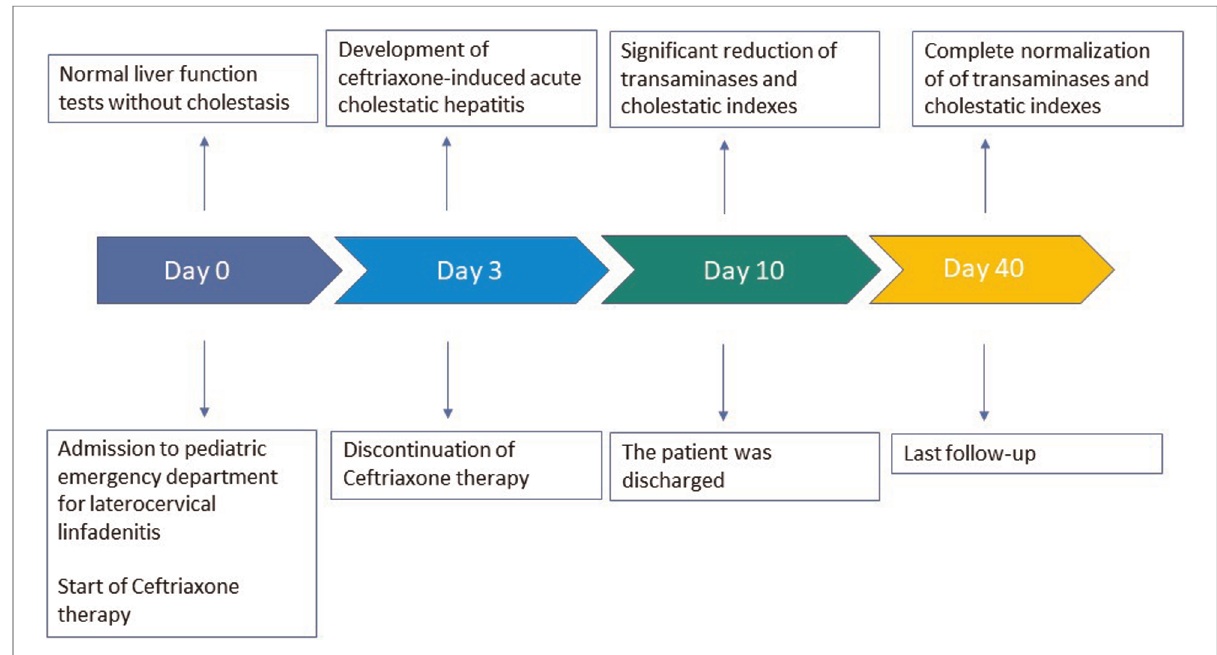
FIGURE 1 Timeline course of the